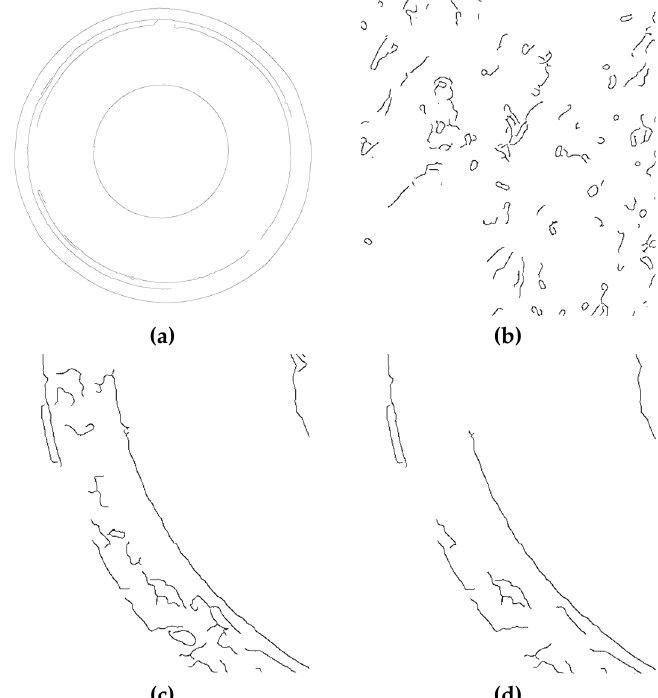
Figure 4. Edge filtering based on length and linearity. (a) Long structural edges; (b) Very short interference details; (c) Pending short edges; (d) Short structural edges with fairly good